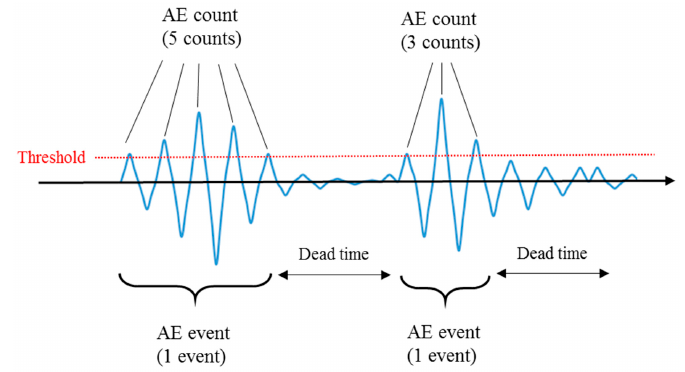
Figure 6. Definition of AE event and AE count.